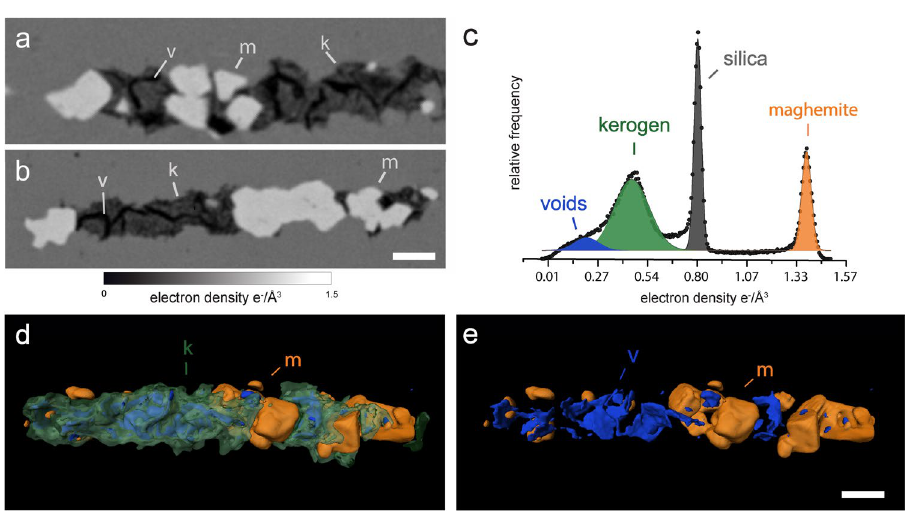
Figure 4. PXCT results for fossil filaments from the Mink Mountain locality. ( a,b ) Details of tomographic virtual slices showing two different fossil filaments within the silica matrix, mostly composed of an irregularly distributed kerogenous material (k). Voids (v) are visible within the kerogen, indicating a high maturity and brittle behavior characteristic of thermal cracking during the generation of fluids and gases. The irregular aspect of the kerogen probably results both from recrystallization of microquartz and brittle deformation with crack formation. The outline of quartz crystals that displaced the kerogen can be observed in the right side of the filament shown in ( a ). Higher density maghemite (m) is present as euhedral and anhedral crystals. ( c ) Histogram of electron density and Gaussian fits obtained from a representative volume of the sample containing the four different phases. The centers of the Gaussians were used for quantitative analysis and identification of the compounds (see Methods). ( d ) 3D detailed segmentation view of a filament showing maghemite crystals with cubic and octahedral morphologies, and kerogen (semi-transparent green) with interior cracks. ( e ) Internal view of the kerogenous region in ( d ) showing the distribution and shape of the cracks (blue). Scale bars: 1 μ